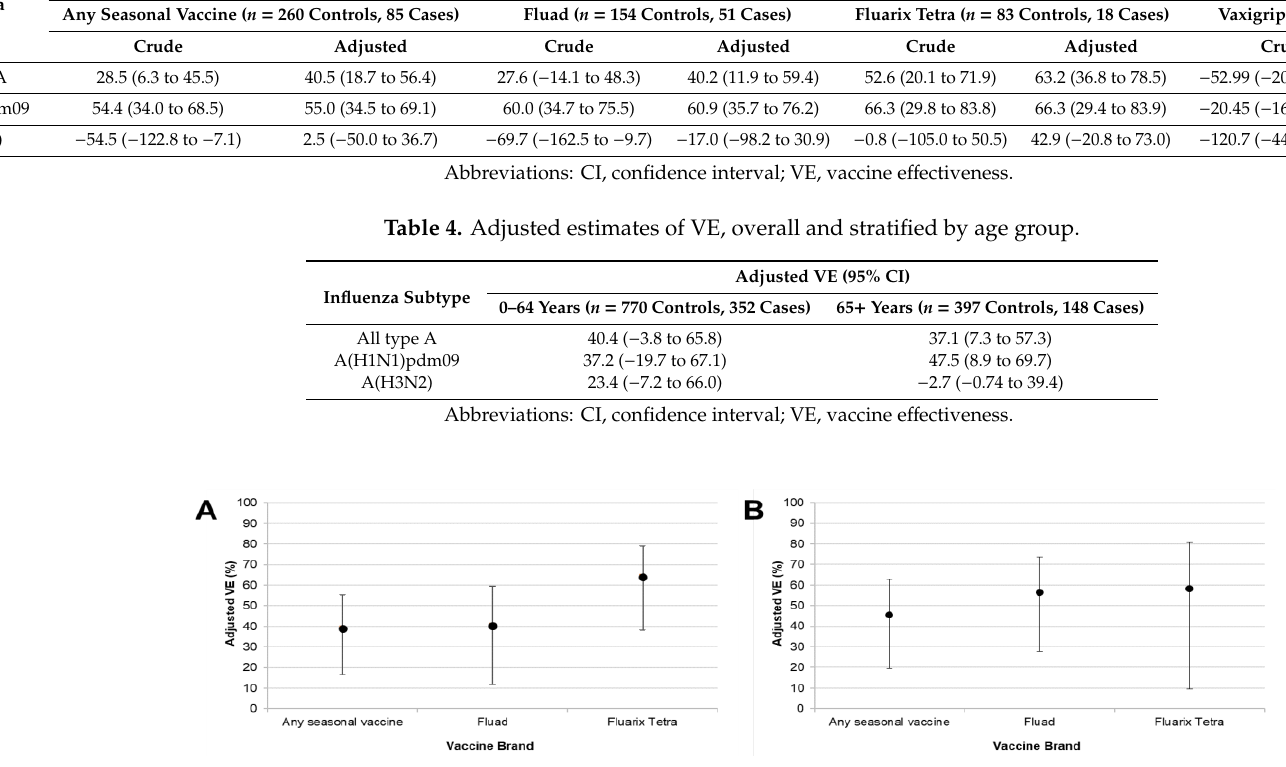
Table 4. Adjusted estimates of VE, overall and stratified by age group.